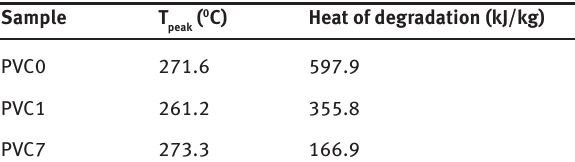
Table 3: Differential Thermal Analysis results of PVC composites.